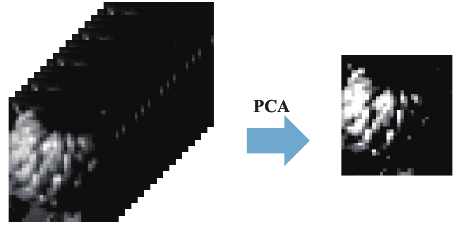
Figure 2. The results after PCA dimensionality reduction.